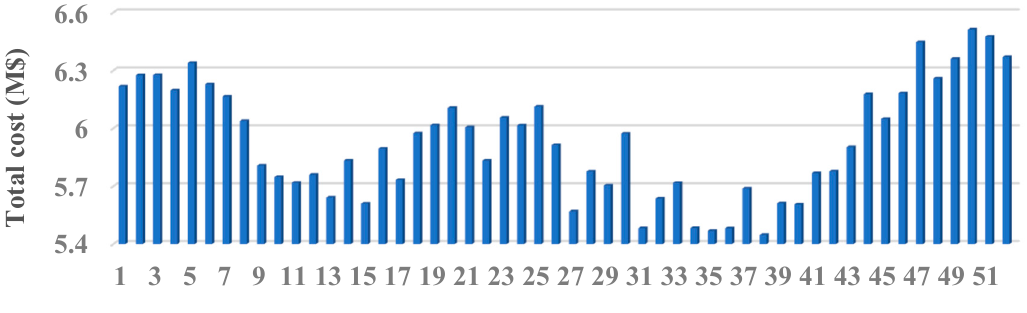
Figure 16. Weekly total cost of the system.